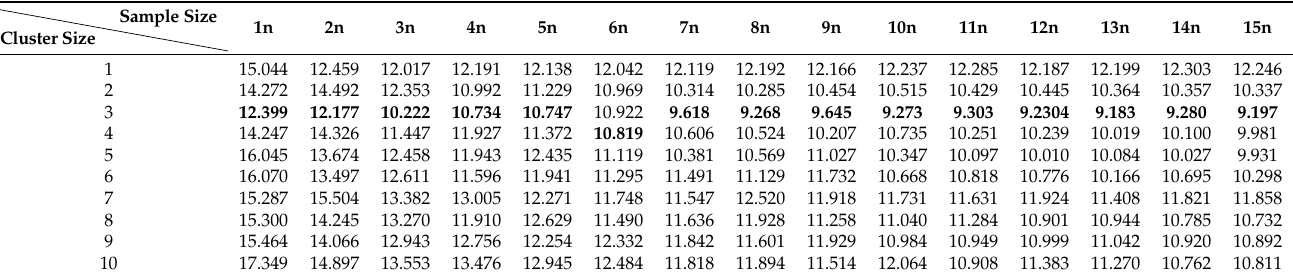
Table 11. MRE comparison with different K for